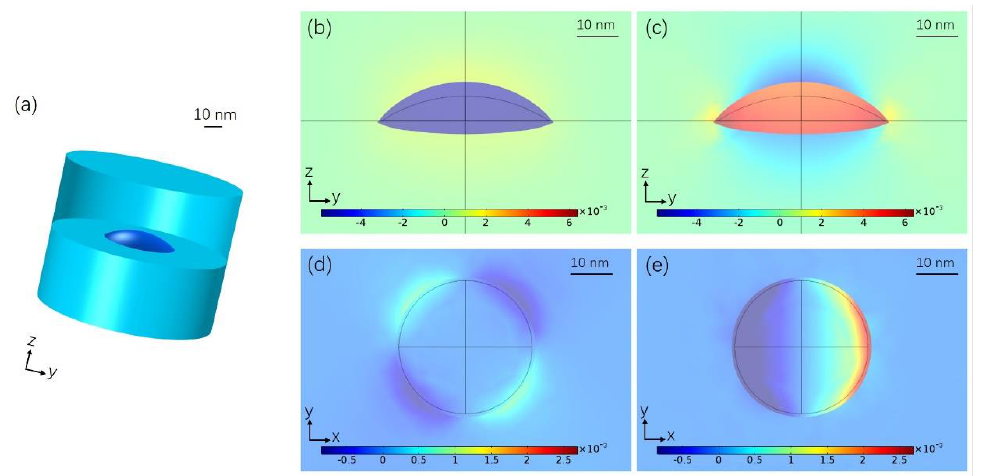
(x) (a) and the aspect ratio (D/H) (b) of the InPBi QD. The ε xx shown in Figure 2a is averaged over the